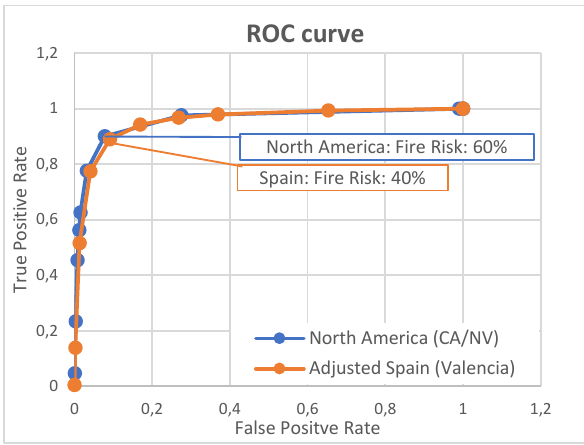
Figure 2: ROC curves for North America (CA/NV) & Spain (Valencia)